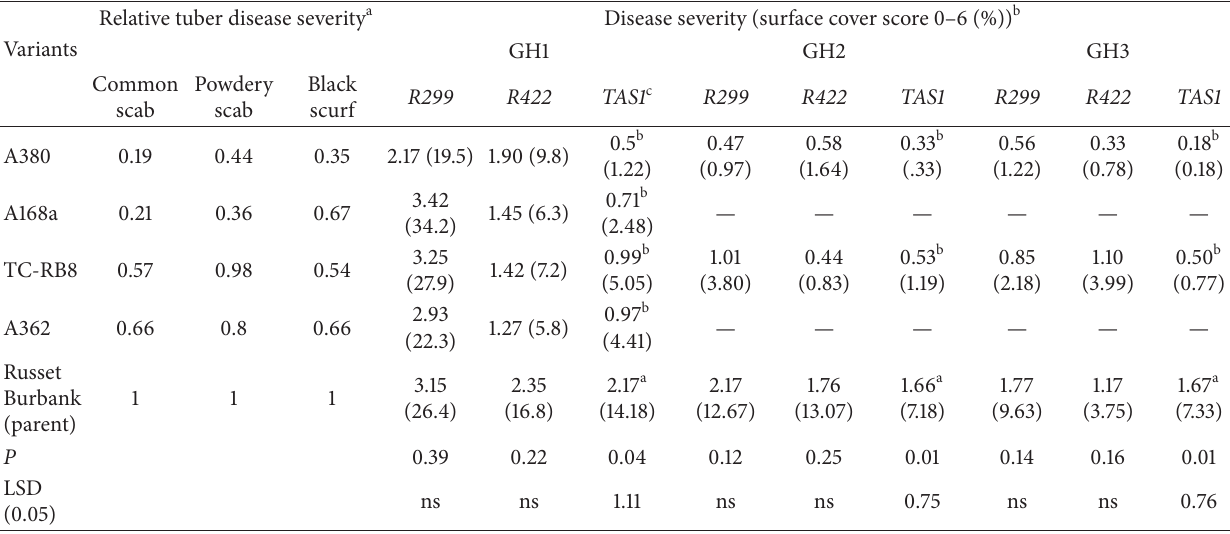
Table 3: Severity of black scurf in selected potato cv. Russet Burbank variants in glasshouse (GH1—2010; GH2 and GH3—2011) trials. Rhizoctonia solani AG3 isolates R299, R422 , and TAS1 were tested separately in each trial. Variants